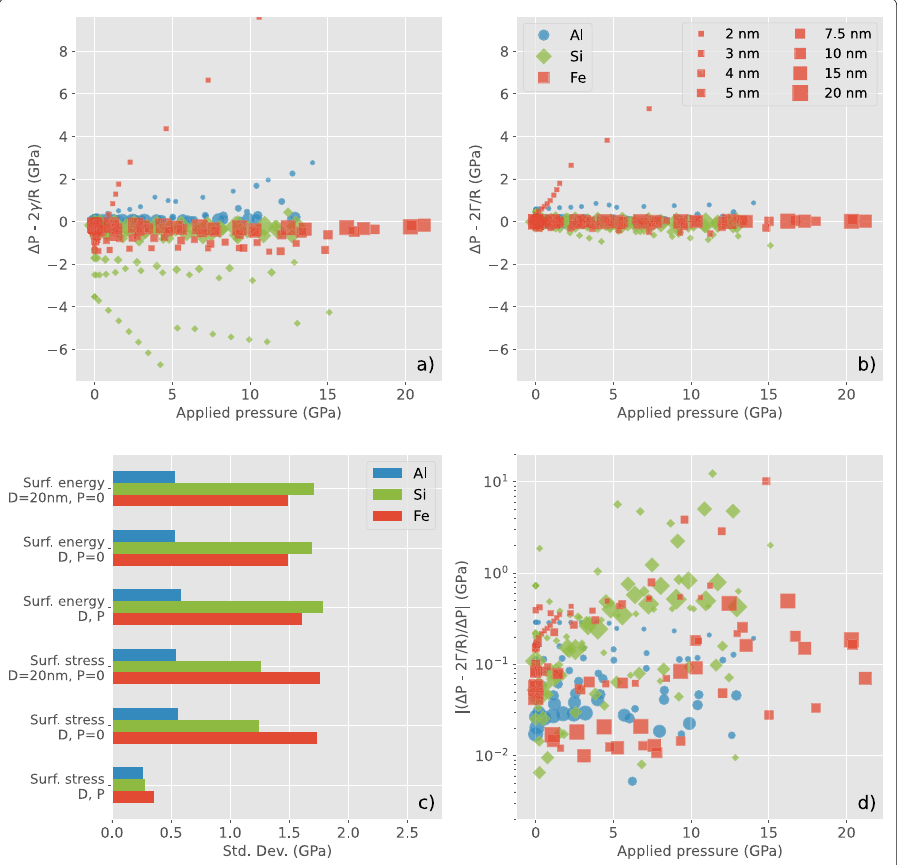
Fig. 7 a) Difference between (cid:2) P and the Laplace pressure for nanoparticles as a function of the applied pressure (Blue circles: Al, green diamond: Si, red squares: Fe). The symbol size is proportional to the diameter. The surface energy of the 20 nm diameter nanoparticle is used to calculate the Laplace pressure. b) same quantity and representation than in a), except that the diameter and pressure dependent surface stress value is now used to compute the Laplace pressure. c) Standard deviation for differences between (cid:2) P and the Laplace pressure for nanoparticles. Each set of bars corresponds to a specific choice for the surface energy/stress used to compute the Laplace pressure (see text for details). d): Relative difference between (cid:2) P and the Laplace pressure for nanoparticles as a function of the applied pressure, using the diameter and pressure dependent surface stress